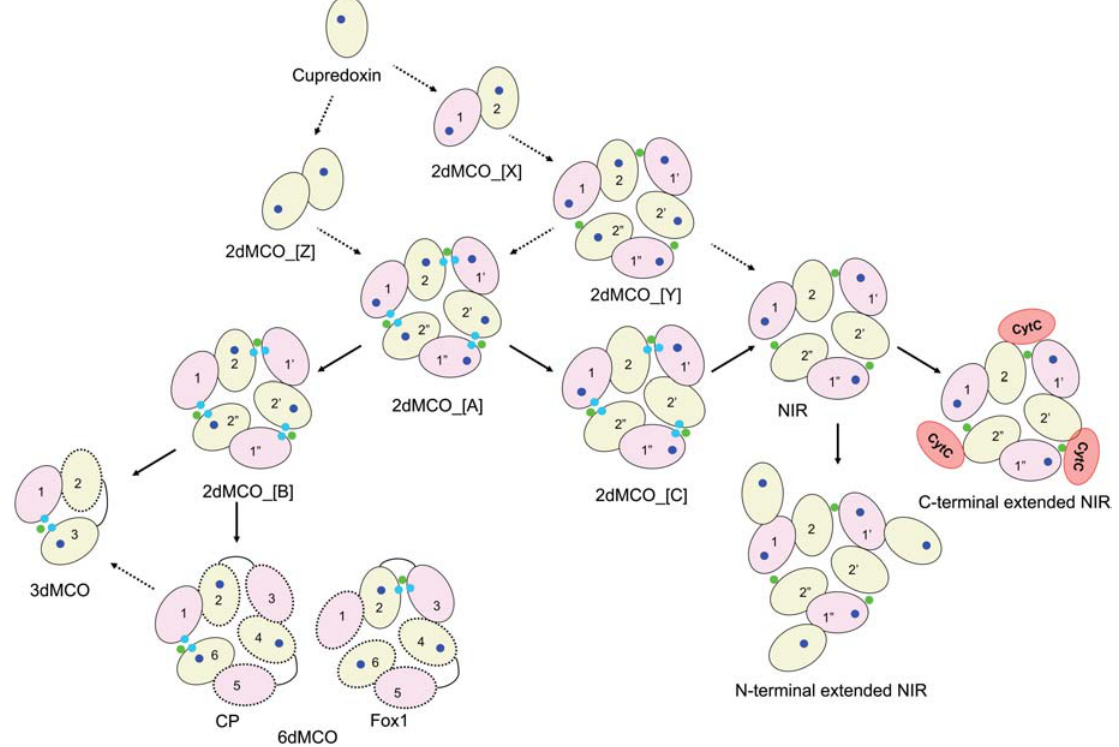
Figure 7 Schematic presentation of the molecular evolution of multicopper proteins. The color code is the same as those used in Figures 3 and